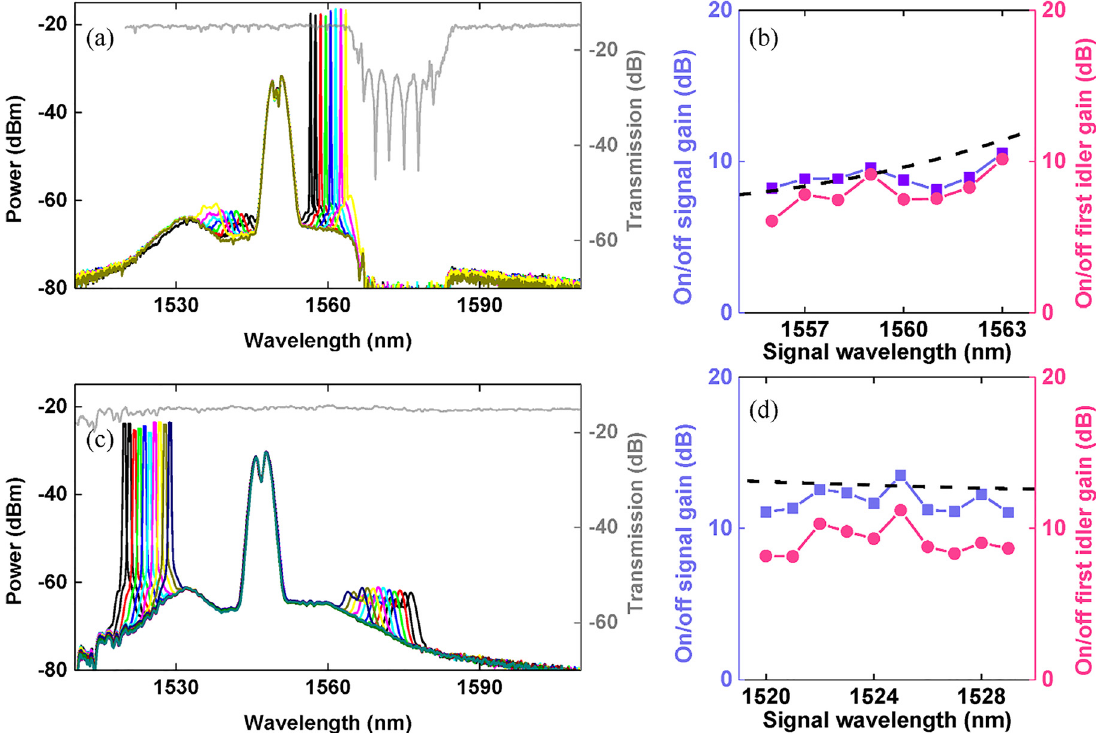
Figure5: FWMspectra(a)andtheiron/offsignaland1stidlergains(b)atsignalwavelengthof1556 – 1563nm.FWMspectra(c)andtheiron/off signal and 1st idler gains (d) at signal wavelength of 1520 – 1529 nm. Black dashed lines in (b) and (d) show the theoretical on/off signal gains which agree well with the experiments. Gray lines depict linear transmission in the dB scale as a function of wavelength. Input peak power is 1.6